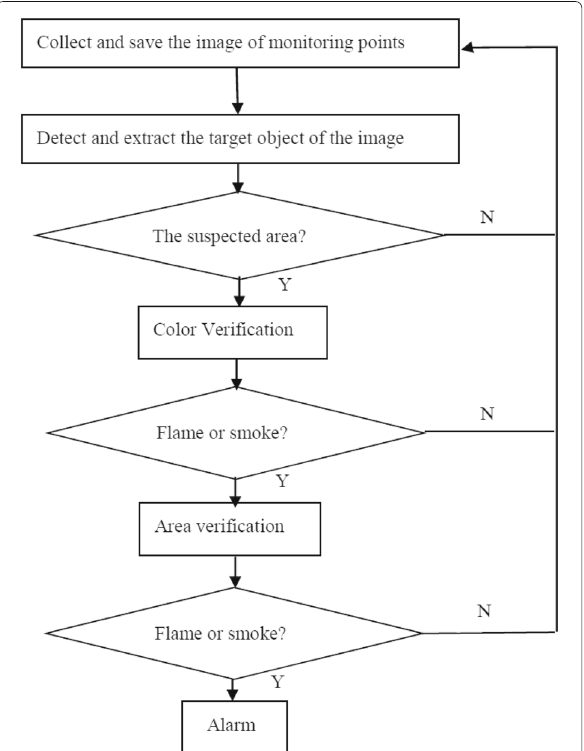
Fig. 3 The flow chart of segmentation